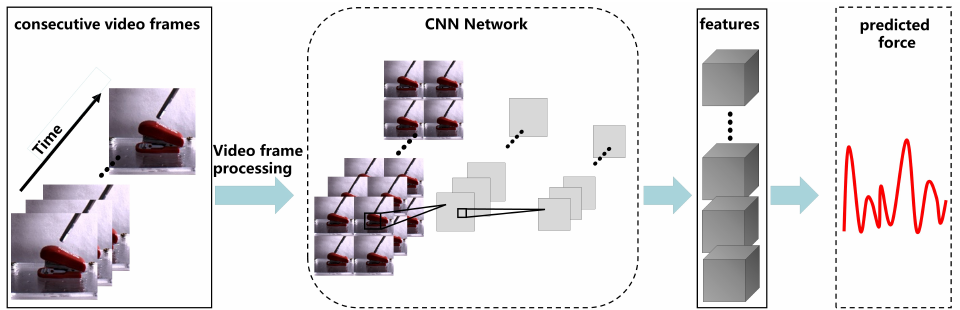
Figure 1. Overall architecture of the